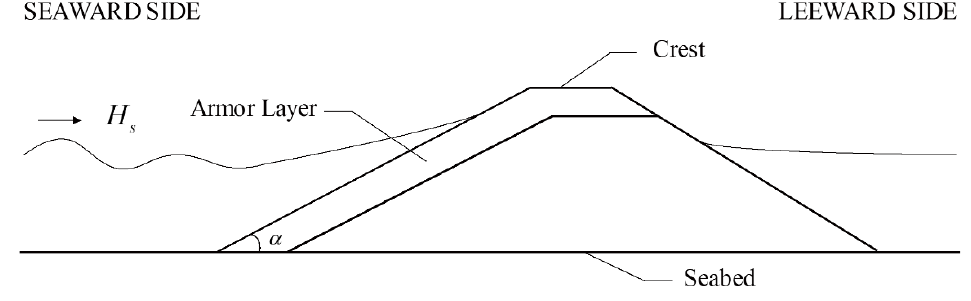
Figure 2. Typical cross-section of rubble mound breakwater.